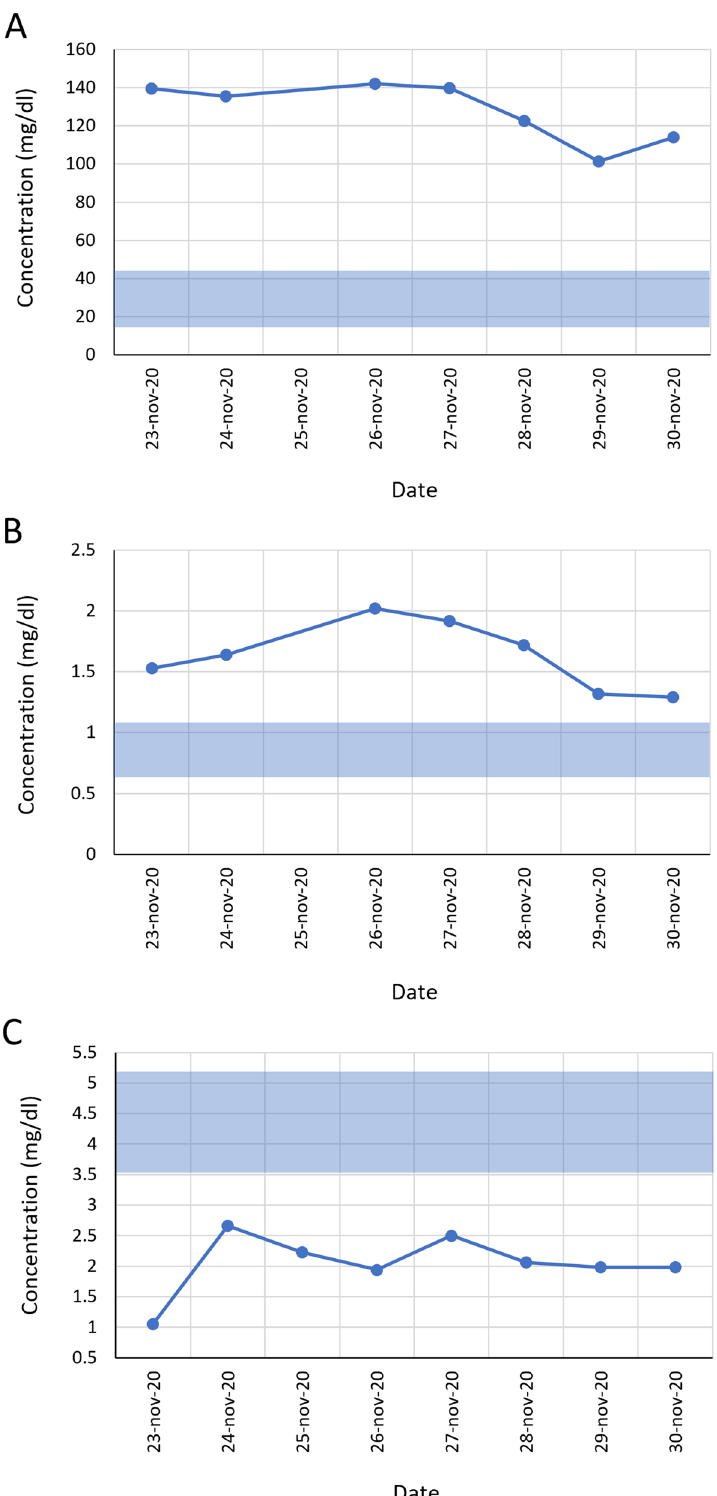
Fig. 2 Renal profile tests. The graphs of ( A ) urea, ( B ) creatinine and ( C ) albumin values measured during the patient’s hospitalization are shown. The solid blue bar represents the reference values for each